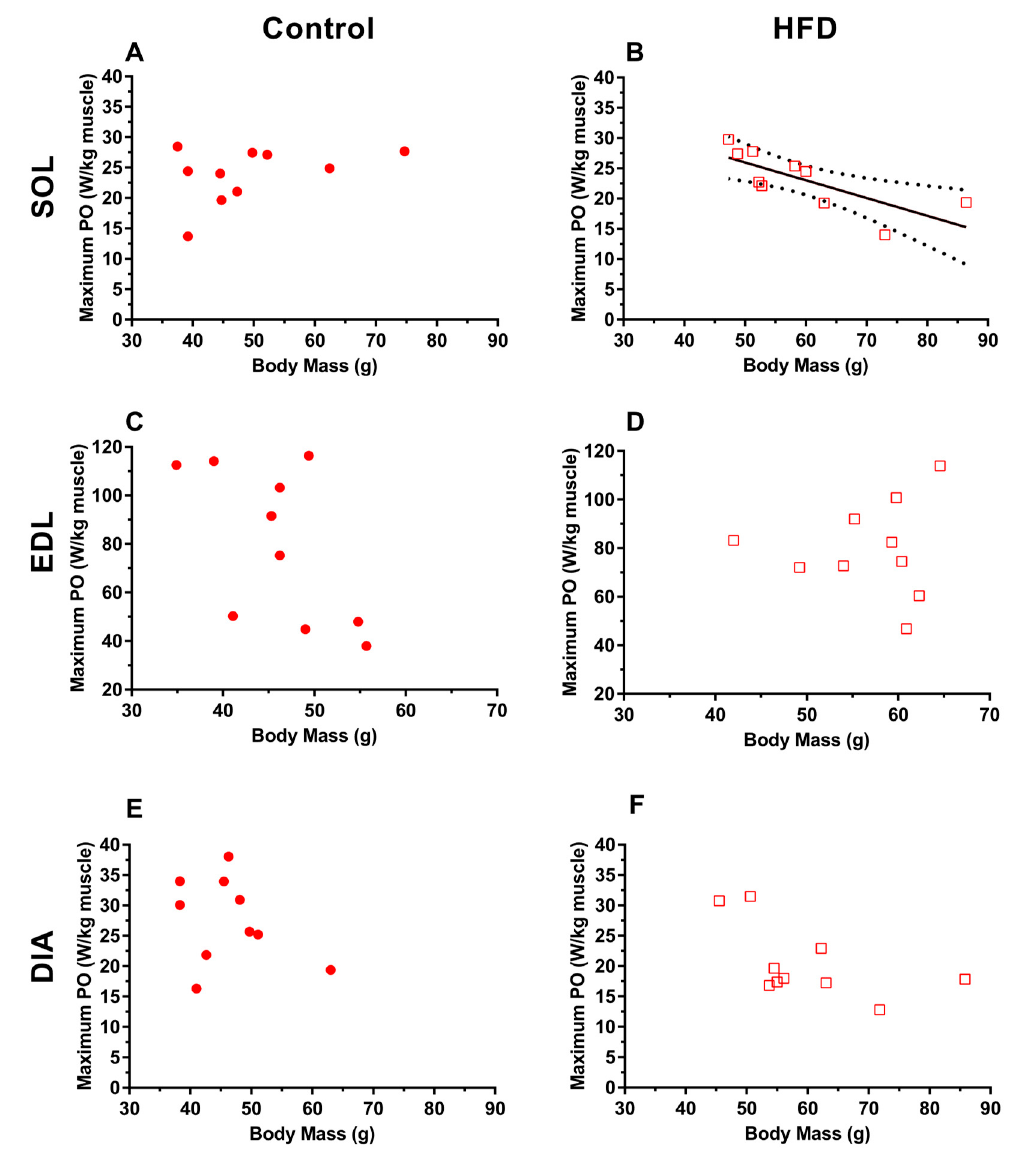
Figure 3. The relationship between whole animal body mass and normalized work loop power for control ( A , C , E ) and HFD ( B , D , F ) soleus ( A , B ), EDL ( C , D ) and diaphragm ( E , F ) experimental groups. n = 10 per muscle per group. For figure ( B ) the lines represent a first-order polynomial fitted to the data using a least squares regression and the 95% confidence limits of this line.